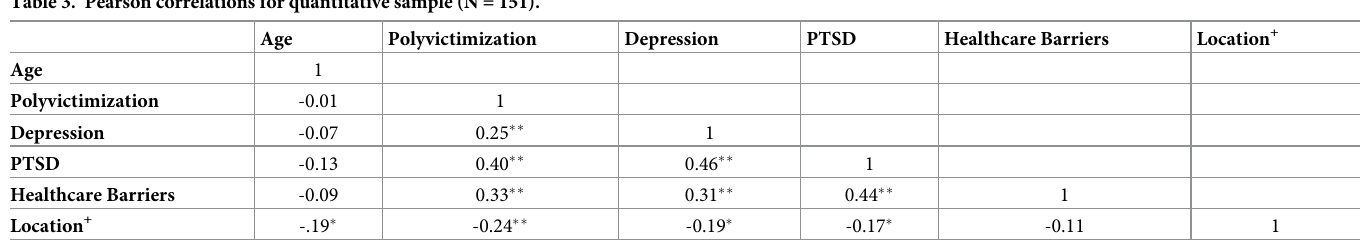
Table 3. Pearson correlations for quantitative sample (N = 151).